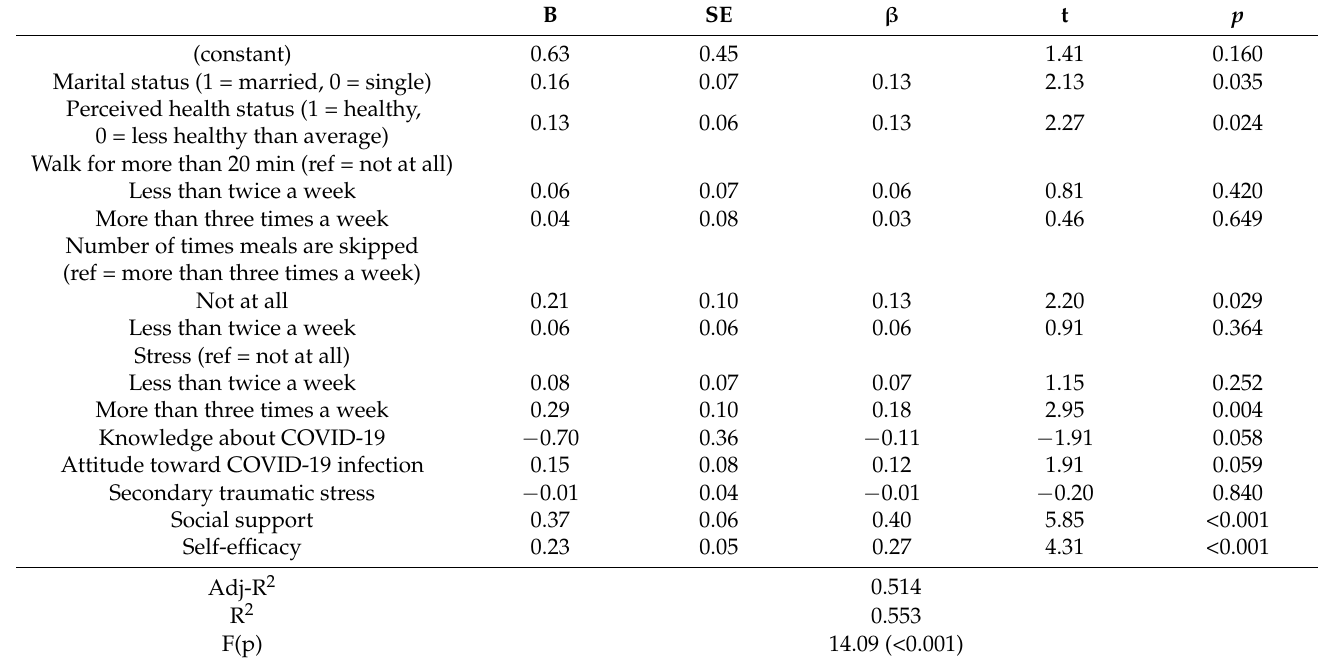
Table 4. Factors Affecting the Participants’ Health Promotion Behavior (N =